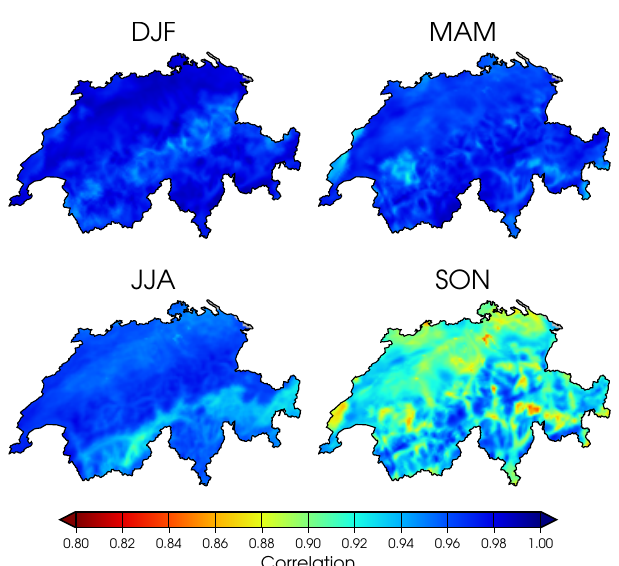
Figure 8. Correlation maps between the daily series of precipitation in the raw WRF-CESM simulation and the output of the bias cor- rected. The analysis is carried out separately by seasons to minimise the effect of the annual cycle on